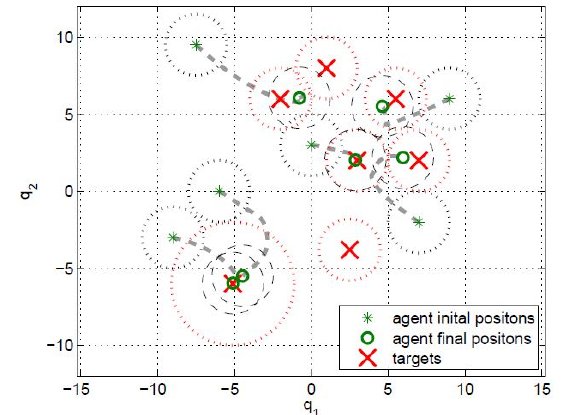
Figure 5. Potential field controller performance (Example